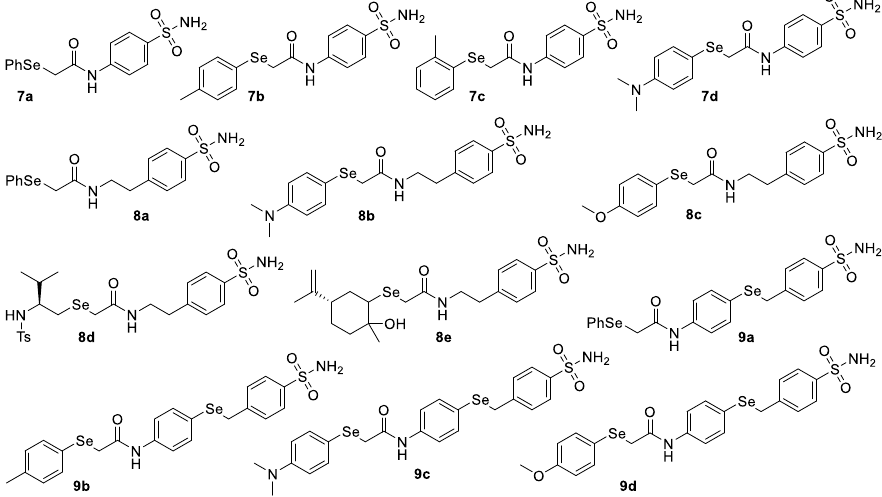
Figure 2. Selenium-containing acetamides bearing the benzenesulfonamide moiety. Int. J. Mol. Sci. 2020 , 21 , x FOR PEER